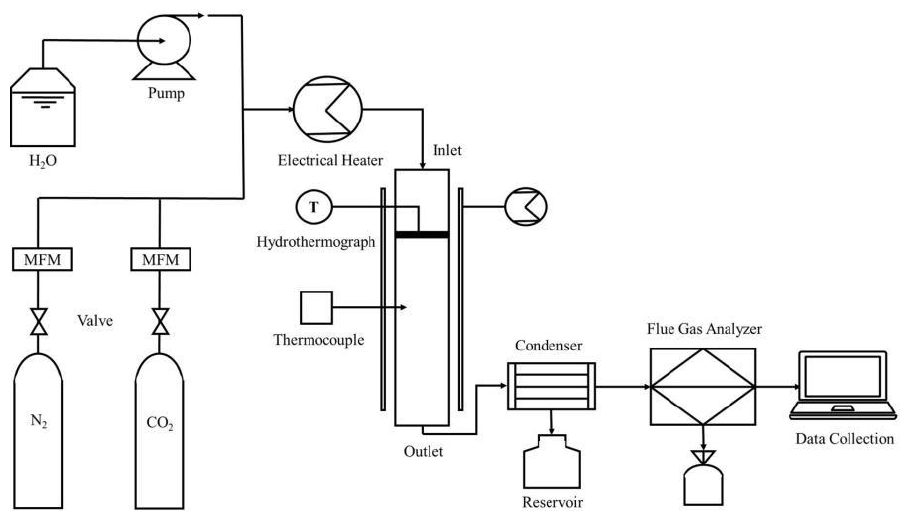
Figure 1. Carbonation reaction system.